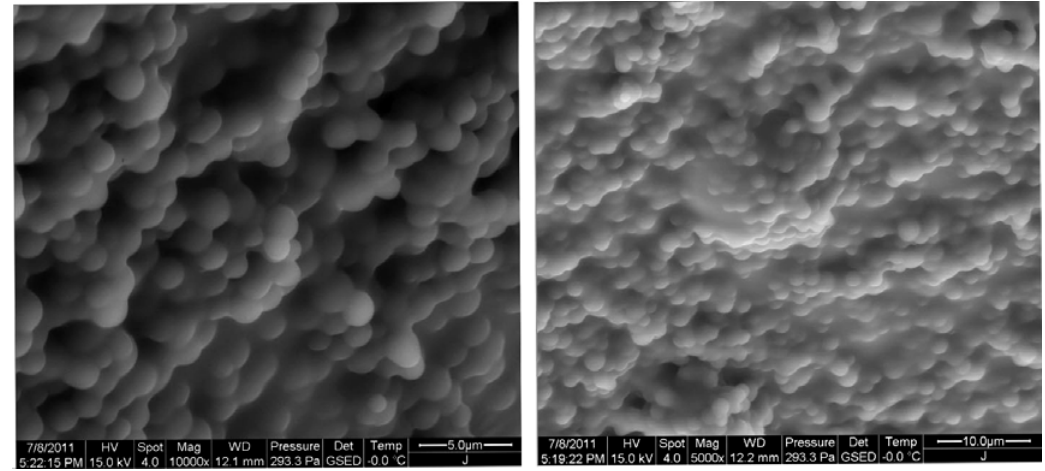
Figure 1. ESEM images of the bulk gel before